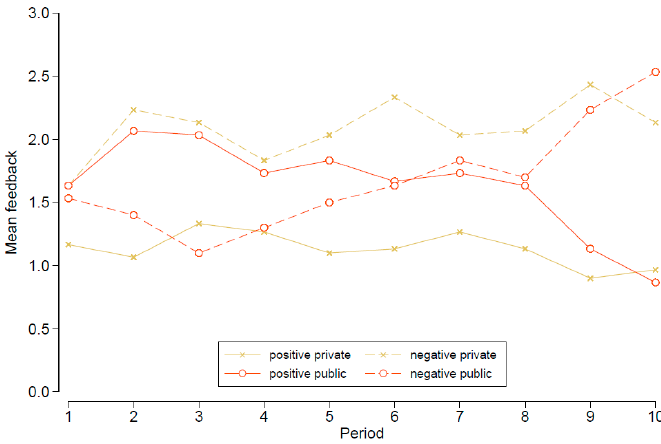
Figure 6. Mean feedback across conditions over time.